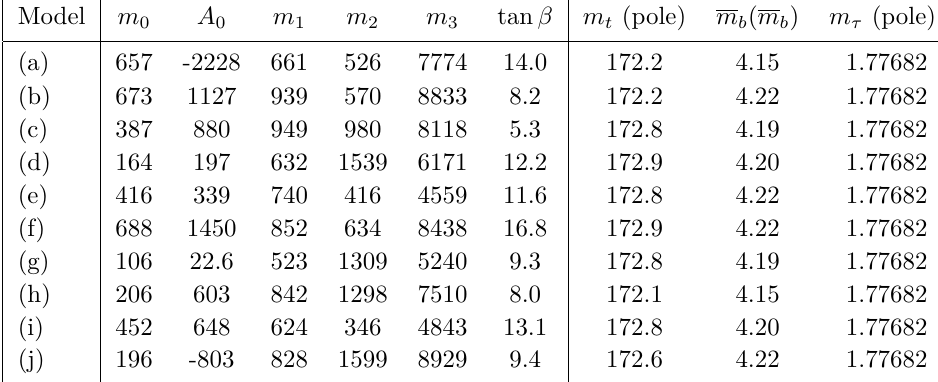
The SUGRA parameters sets used for RG analysis where the boundary conditions for the Yukawas for the top, bottom, and the tau are taken from table 5. In the analysis the GUT scale ranges from 8 . 6 × 10 15 GeV to 2 . 0 × 10 16